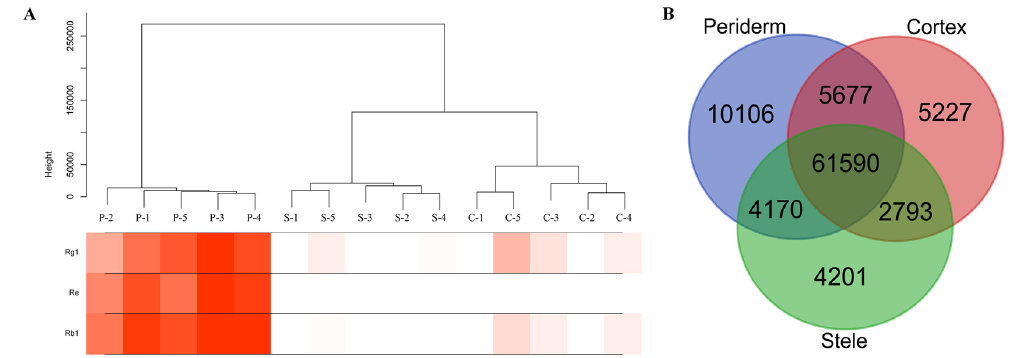
Figure 2. Clustering analysis of expression genes in ginseng main root tissues. ( A ) Clustering tree for expression genes in ginseng main root tissues. The leaves of the tree correspond to the three tissues with five duplicates. The color bands beneath the tree represent the relative content of the ginsenoside-Rg1, ginsenoside-Re, and ginsenoside-Rb1, with red indicating high values. P, C, and S refer to the periderm, cortex, and stele, respectively. ( B ) Venn diagram showing the overlap between the expression genes of each root tissue.